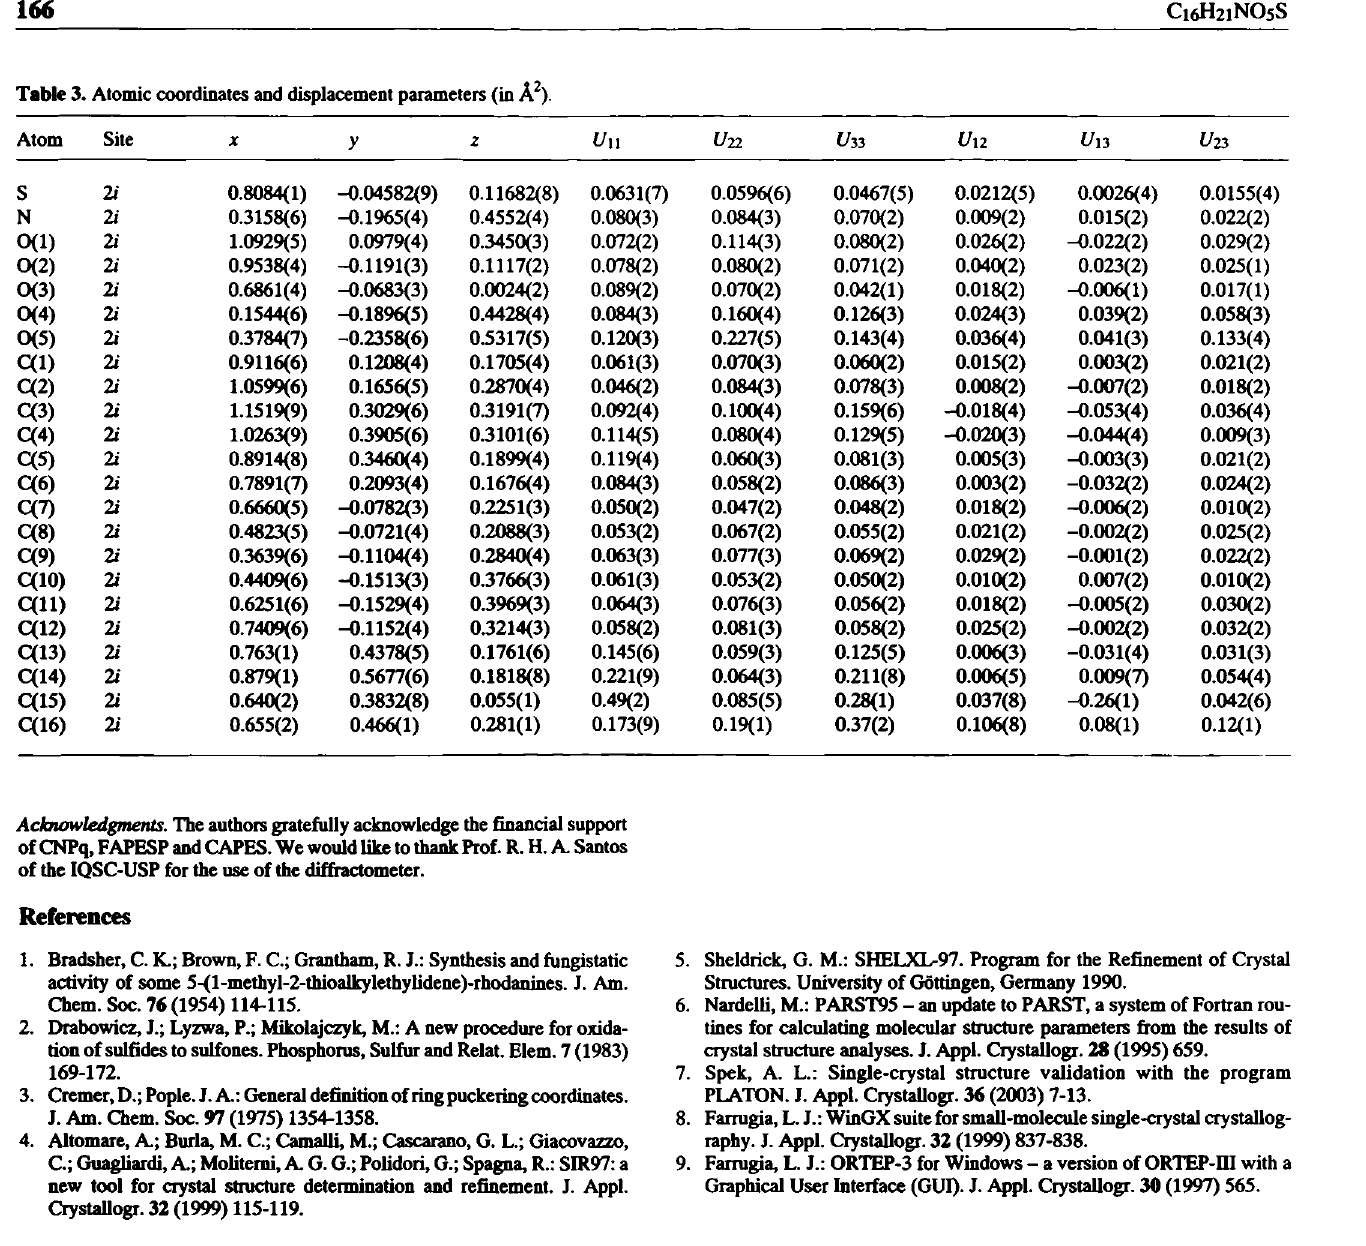
Table 3. Atomic coordinates and displacement parameters (in A 2